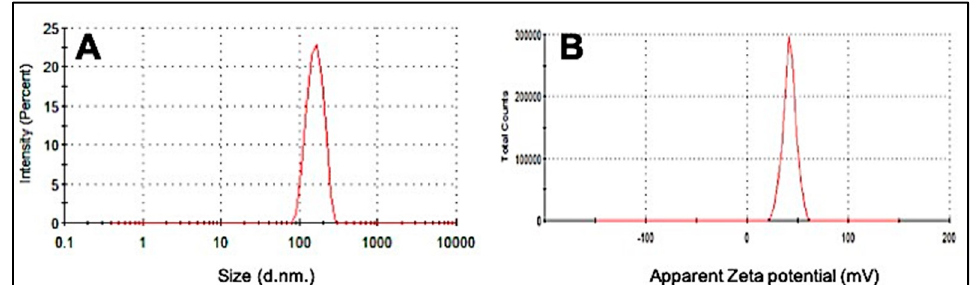
Figure 1. Dynamic light scattering ( DLS) images of ( A ) average particle size distribution of CS Nanoparticle and ( B ) Zeta potential of synthesized CS Nanoparticle.